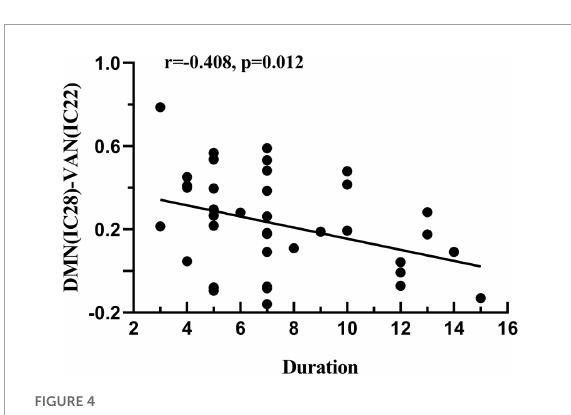
FIGURE4 Correlation between the FNC coefficient and the clinical features in acute patients with hearing loss. DMN-VAN connection was found to be negatively correlated with duration ( r = –0.408, p =